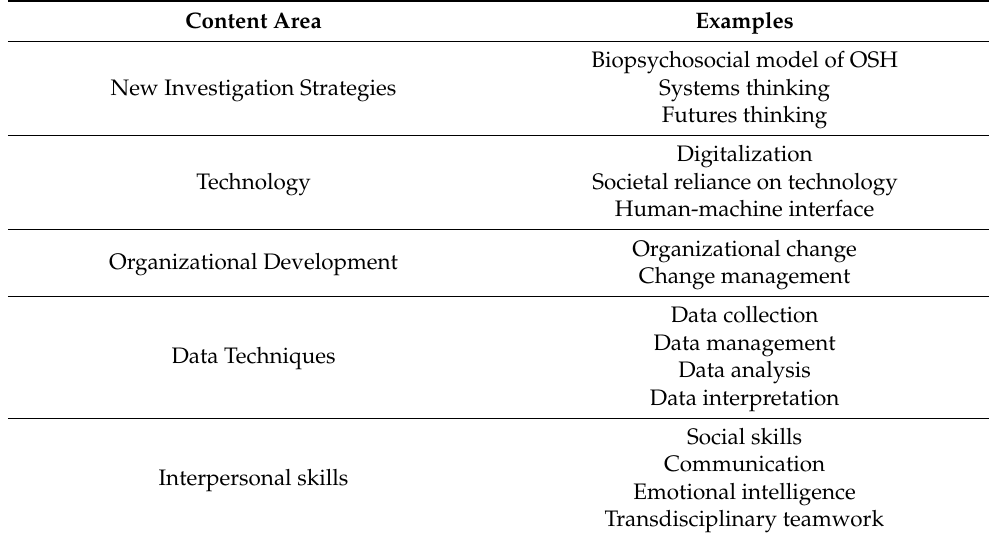
Table 3. Key Content Areas for Training OSH Professionals